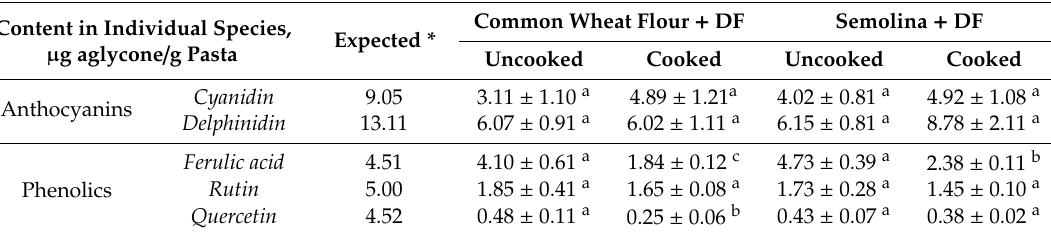
Table 3. Content of representative aglycones in enriched